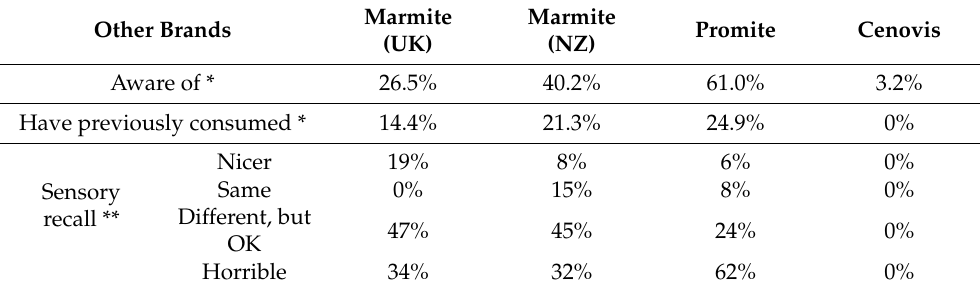
Table 5. Awareness and consumption of other (national) yeast spreads brands in Australia ( n = 249). Marmite Other Brands